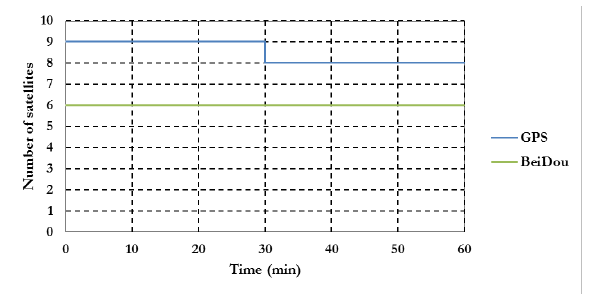
Figure 2: DLF1 station GNSS satellite availability.